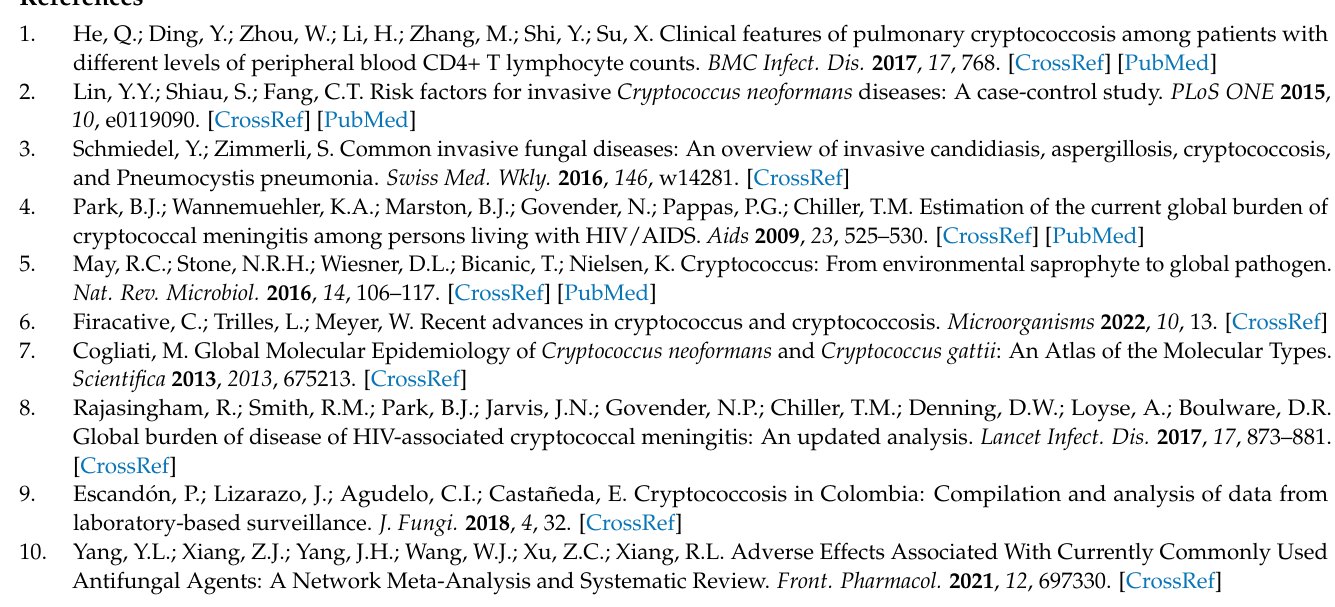
Figure S1: Effect of the physical combination between: [K]-BFII (32–35) Pal : (KLLKKLLK) and LfcinB (20–25): (RRWQWR); [K]-LfcinB (20–25): (KKWQWK) and BFII (32–35) Pal : (RLLRRLLR); Figure S2: Chemical characteristics of